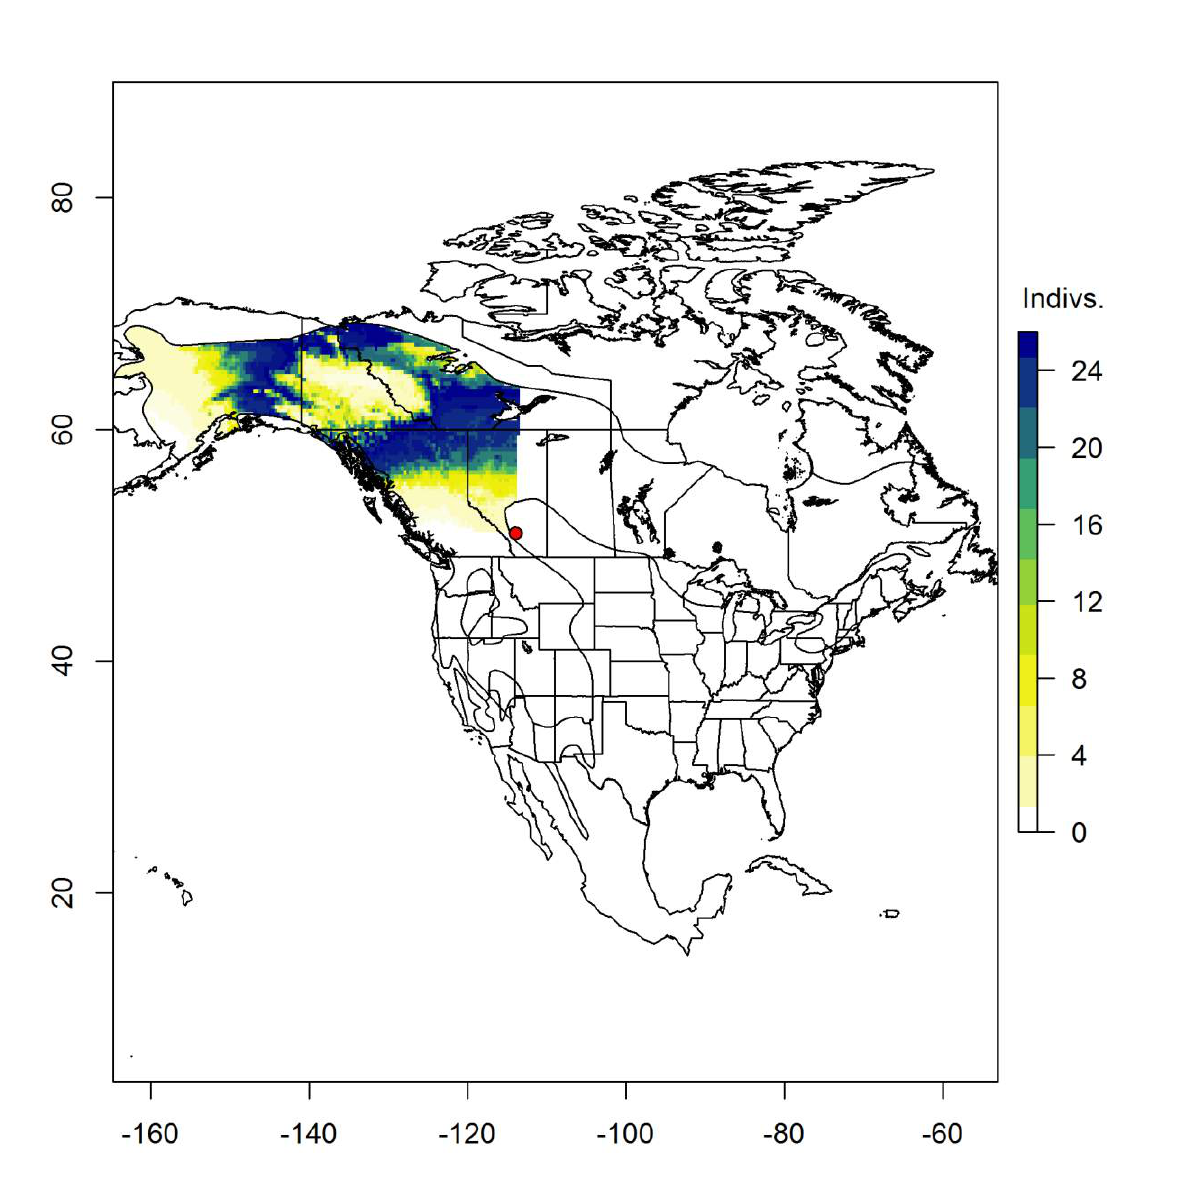
Figure A2.8: Probable origins of Ovenbirds ( Seiurus aurocapilla ) captured during fall migration at the IBS CMMN station in Southern Alberta